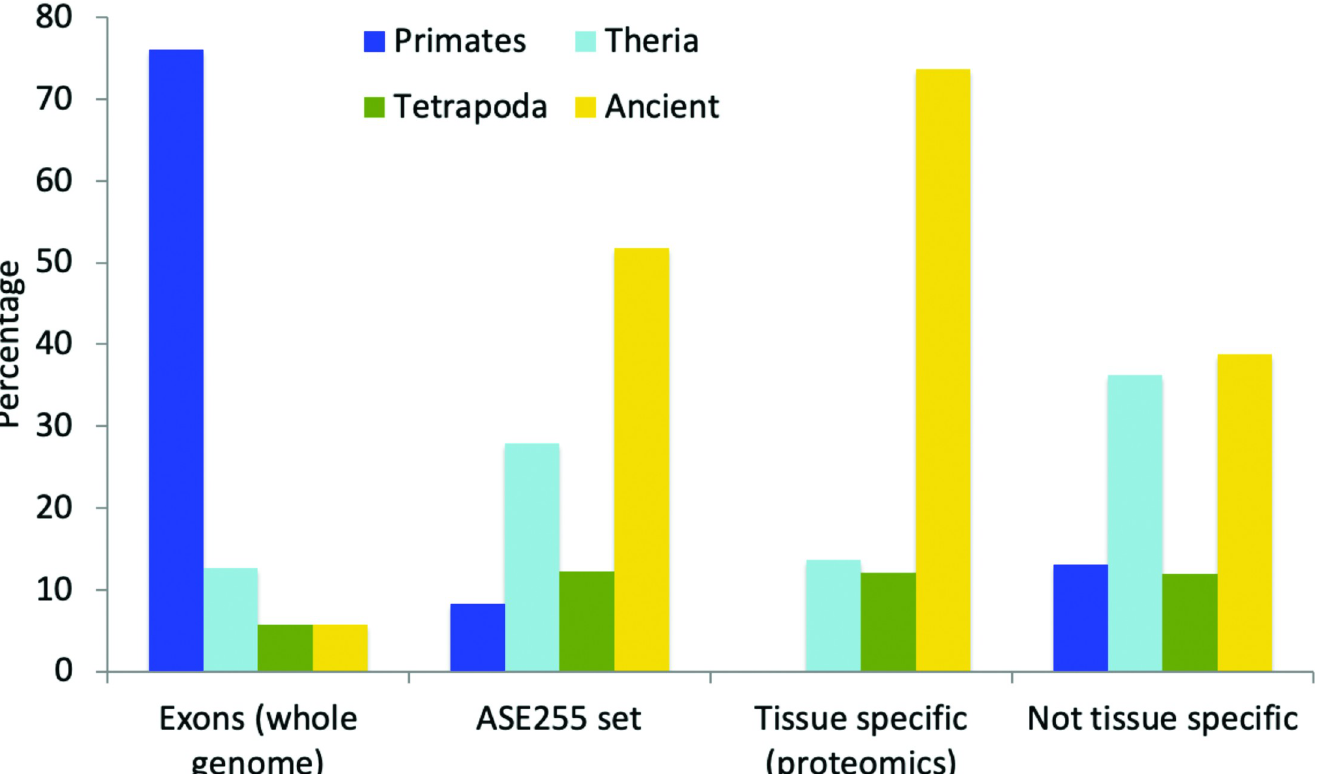
Fig 3. The age of alternative exons versus subsets of splicing events detected in proteomics experiments. “Exons (whole genome)” are all alternative exons in the human genome, “ASE255 set”is the set of 255 alternative splicing events detected in the proteomics analysis, “Tissue-specific (proteomics)” are the 95 events that have significant tissue or group-specific differences at the protein level and “Not tissue specific” are the 161 events that do not have tissue-specific enrichment in proteomics experiments.